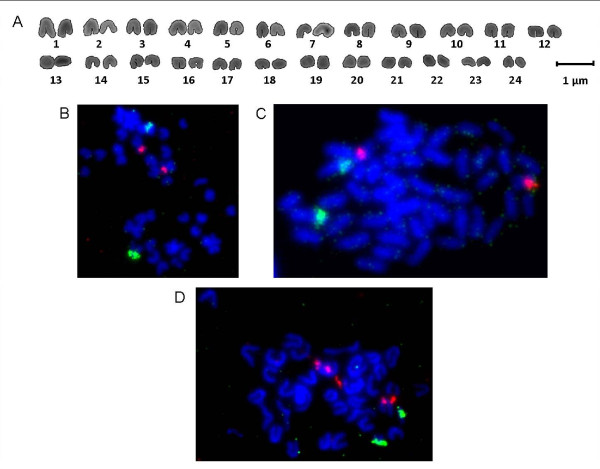
Karyotype and Fluorescencein situHybridization inPlectorhinchus mediterraneus. Karyotype of P. mediterraneus composed of 24 acrocentric chromosome pairs (A). Double-FISH treatment to localize simultaneously the 5S rDNA (red) and 18S rRNA genes (green) (B); U2-U5 snRNA gene (red) and 18S rRNA gene (green) (C); and U2-U5 snRNA gene (red) and 5S rDNA (green) (D).